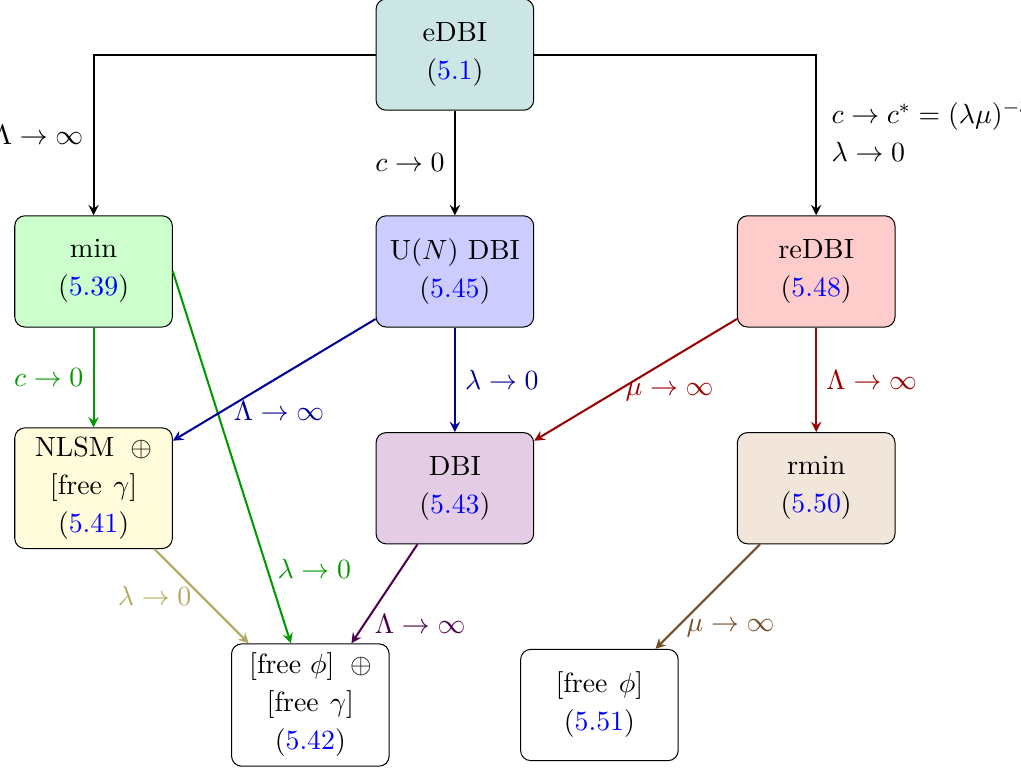
Figure 3 . Web of limits for the extended DBI